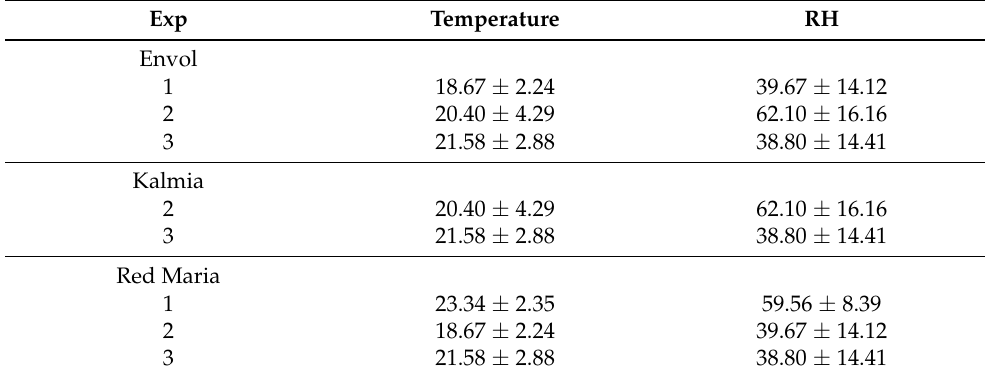
Table 1. Mean temperatures ( ◦ C) and relative humidity (RH, %) over the different growing seasons for the three